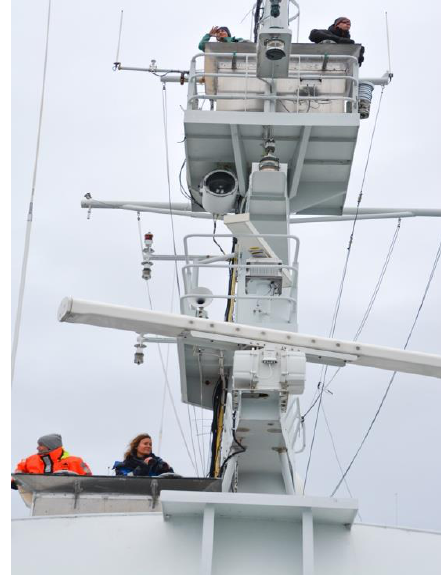
Figure 2. Platform 1 (upper) and platform 2 (lower) aboard the ACC Mosby. Photo credit: Deanna Leonard All survey effort was conducted at a speed of 10 knots at a Beaufort Sea State (BSS) of 4 or less with visibility greater than 1 km. On an hourly basis and as conditions changed, the weather conditions, BSS, visibility, and glare were recorded. More detail on the survey design, observer protocols, and covariate classification is provided in Øien